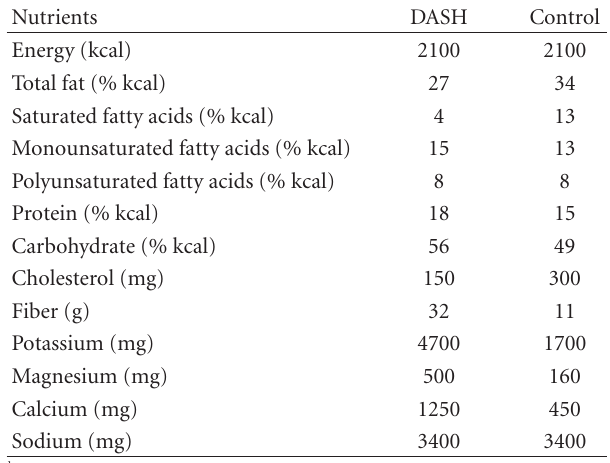
Table 1: Nutrient composition of the two dietary assignments.